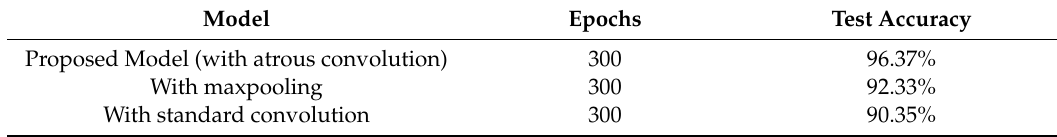
Table 2. Model comparison with or without the atrous